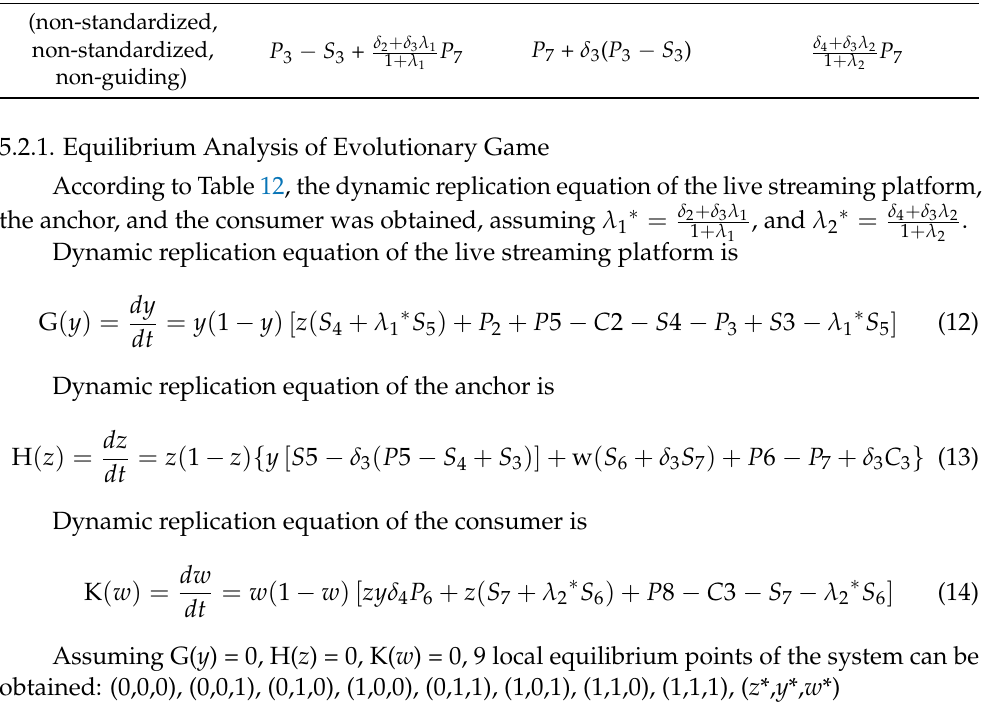
Table 12. Cont. Strategy (non-standardized, non-standardized,